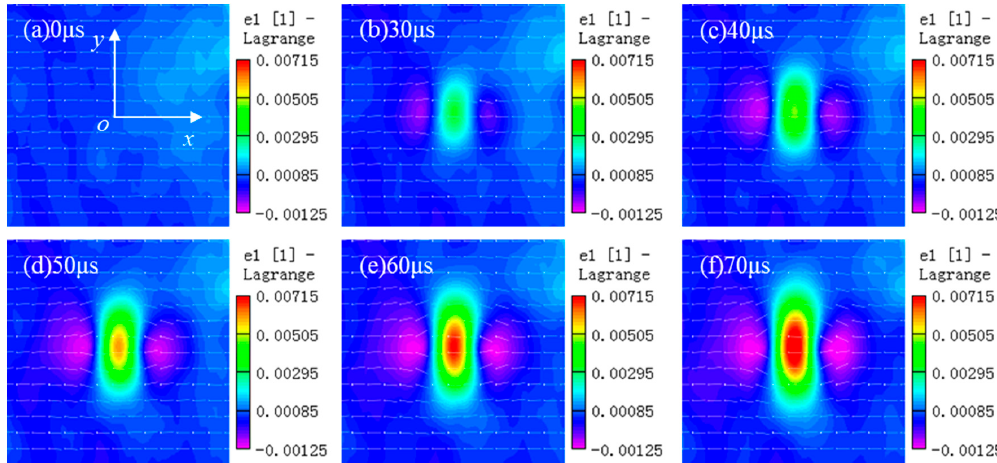
Figure 6. Magnitude and direction of maximum principal strain on the free surface in case of uniaxial static load: ( a – f ) images of maximum principal strain after 0 μ s, 30 μ s, 40 μ s, 50 μ s, 60 μ s and 70 μ s of explosion.